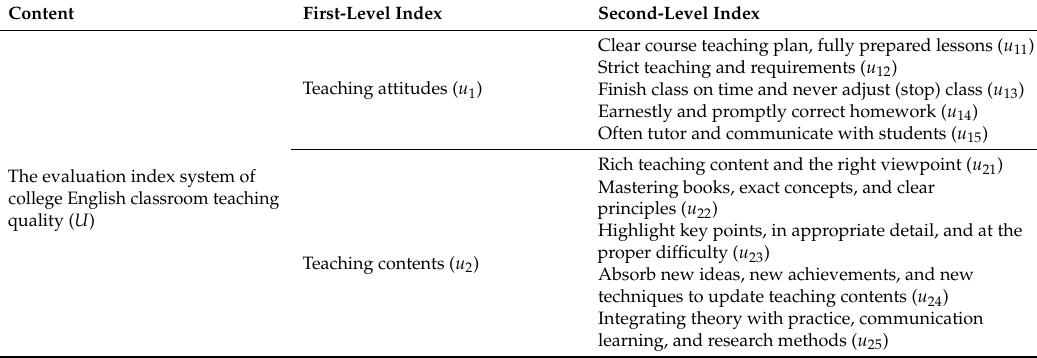
Table 1. The quality evaluation index system of college English classroom